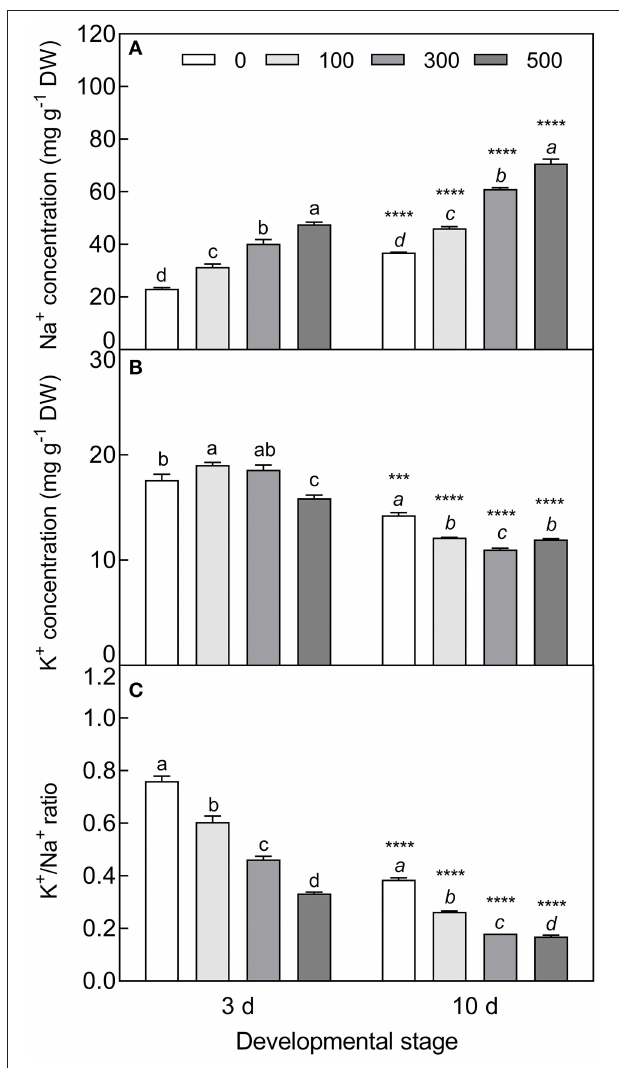
FIGURE 9 | Changes in Na + and K + during seedling development under salt stress. (A) Na + , (B) K + , and (C) K + /Na + ratio. 3 d and 10 d: represent 3 and 10 days after seedling emergence, respectively. 0, 100, 300, and 500: different NaCl concentrations (mM). Bars with different lowercase letters of the same developmental stage indicate significant differences ( P < 0.05) at different concentrations; *** and **** indicate a significant difference between 3 d and 10 d at the same salt concentration at 0.001 and 0.0001 levels, respectively. Values are means ± SE of three